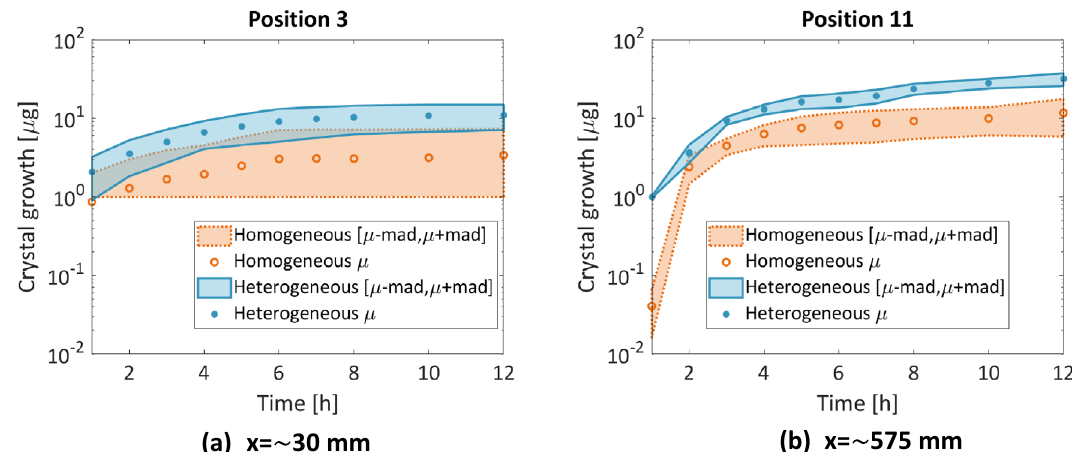
Figure 9. Crystal mass growth during 12 h of MICP treatment at two positions: ( a ) x = 30 mm and ( b ) x = 574 mm along the homogeneous and heterogeneous porous medium. Dots represent averages of the triplicates; shaded areas represent the mean absolute